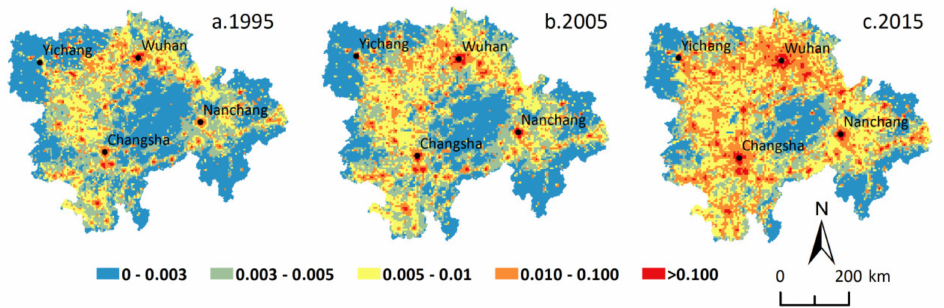
Figure 2. Spatial distribution of urbanization level in the Middle Reaches of the Yangtze River Urban Agglomerations at 5 km grid scale. Note: Reprinted with permission from Chen et al. (2020). Copyright 2020 China University of Geosciences (Wuhan).